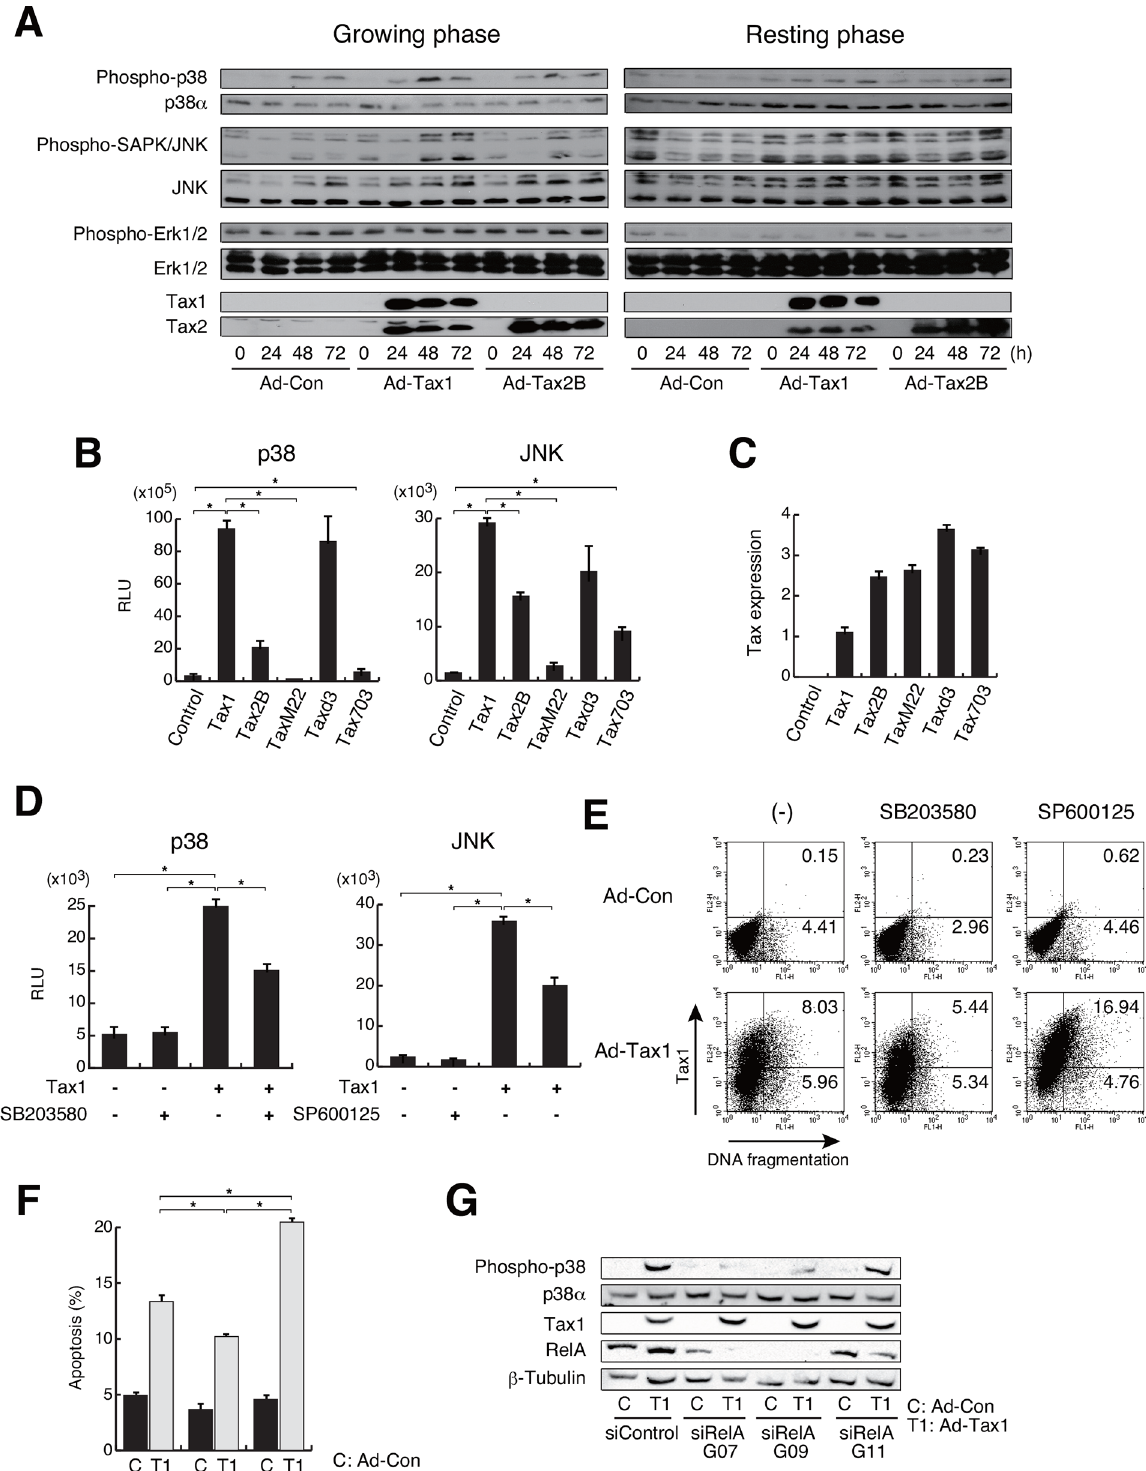
Fig 10. Activation of MAP kinase pathways by Tax1. (A) Growing or resting Kit 225 cells were infected with Ad-Tax1 or Ad-Tax2B, and cultured for indicated times. Phosphorylation and expression of p38, JNK and ERK were analyzed by western blotting. Expression of adenovirus-derived Tax1 and Tax2B in Kit 225 cells was detected with anti-Tax1 (Lt-4) and anti-Tax2 (GP3738) antibodies, respectively. (B and D) Growing Kit 225 cells were transfected